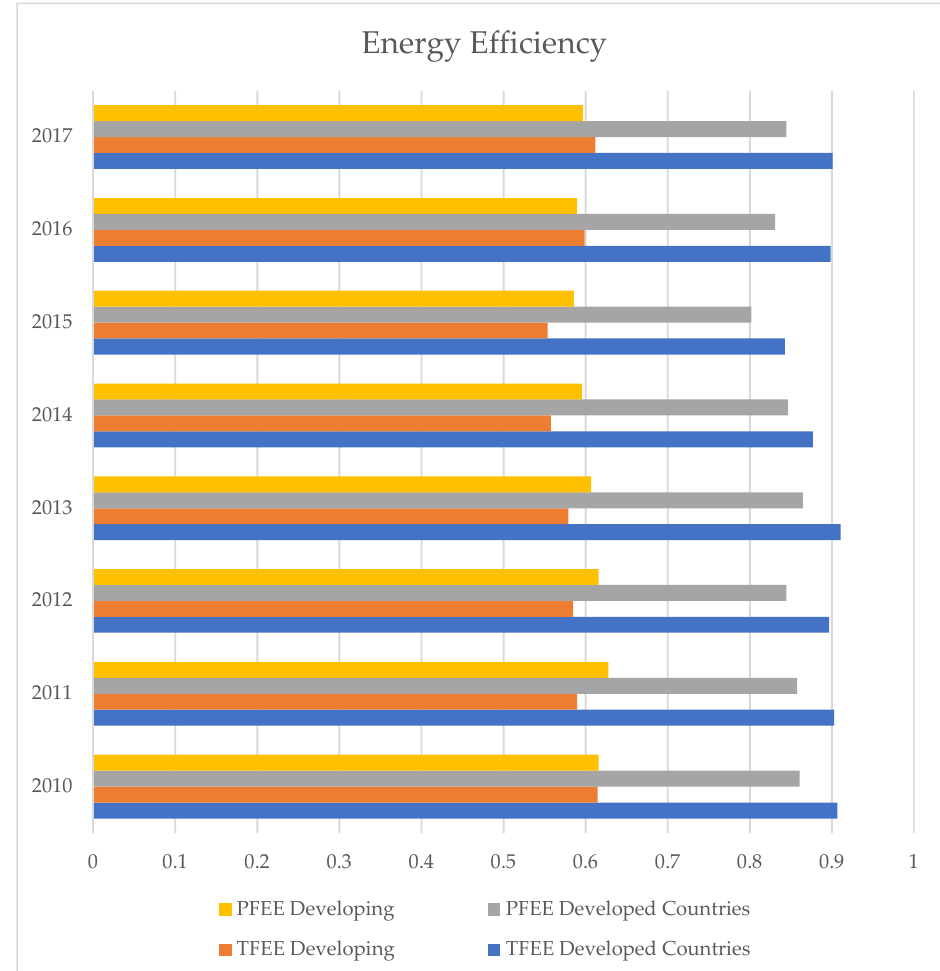
Figure 1 . Average energy efficiency score of developing and developed countries. Figure 1. Average energy e ffi ciency score of developing and developed countries.